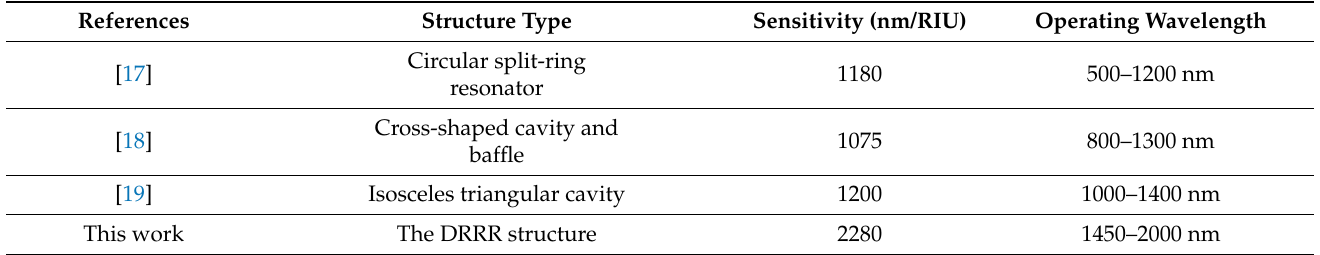
Table 1. Comparison of structural